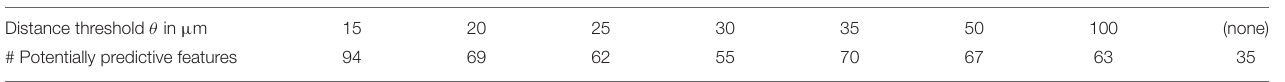
TABLE 3 | Numbers of potentially predictive features based on cell-to-cell distances with different distance thresholds and density-based features. Distance threshold θ in µ